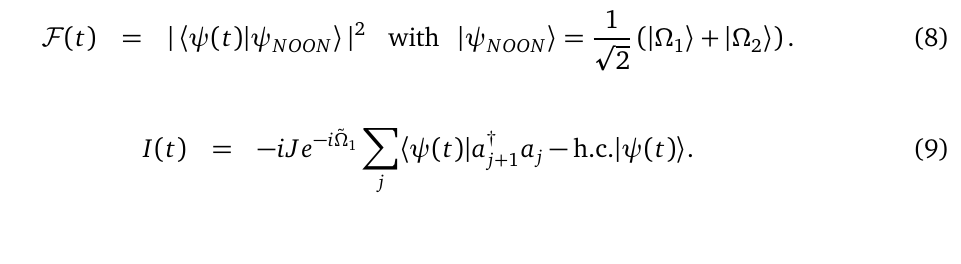
〉 and | Ω 〉 are dynamically 1 2